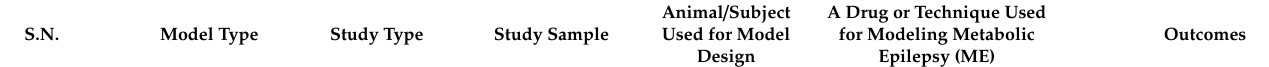
Table 1. Tabular representation of animal models in